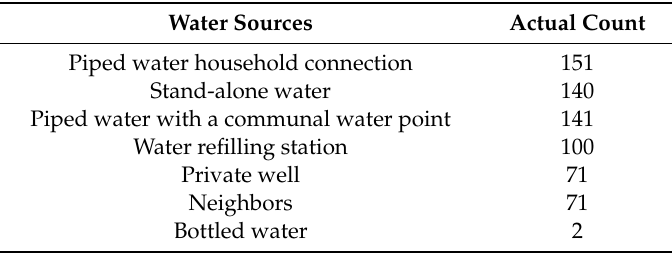
Table 3. Water sources for daily consumption in